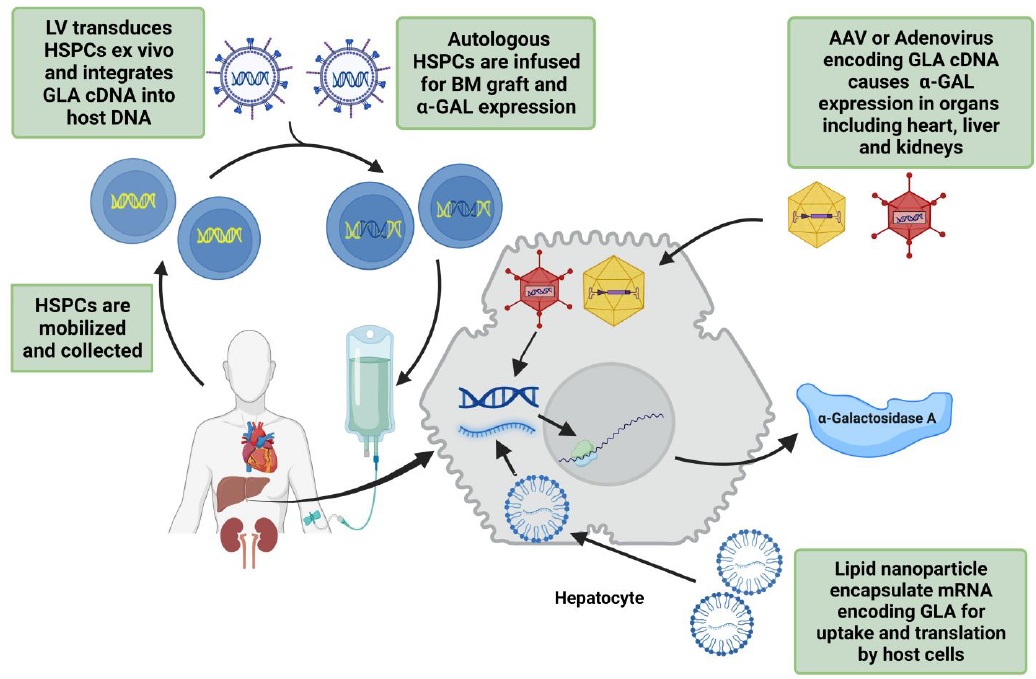
Figure 3. Overview of the gene therapy techniques being used in trials for FD treatment. The first step is to mobilize hematopoietic stem/progenitor cells (HSPCs) and integrate GLA cDNA into host DNA using lentivirus (LV). These transduced HSPCs are transplanted back into bone marrow for α - galactosidase A (α -GAL) expression. Adeno-associated virus (AAV) or adenovirus can also be used for GLA cDNA transfer into target cells. Lipid nanoparticle encapsulated mRNA encoding human GLA is another safe method of endogenous α -GAL expression. Lentivirus (LV)-based strategies insert GLA cDNA into the genomic DNA of hema-